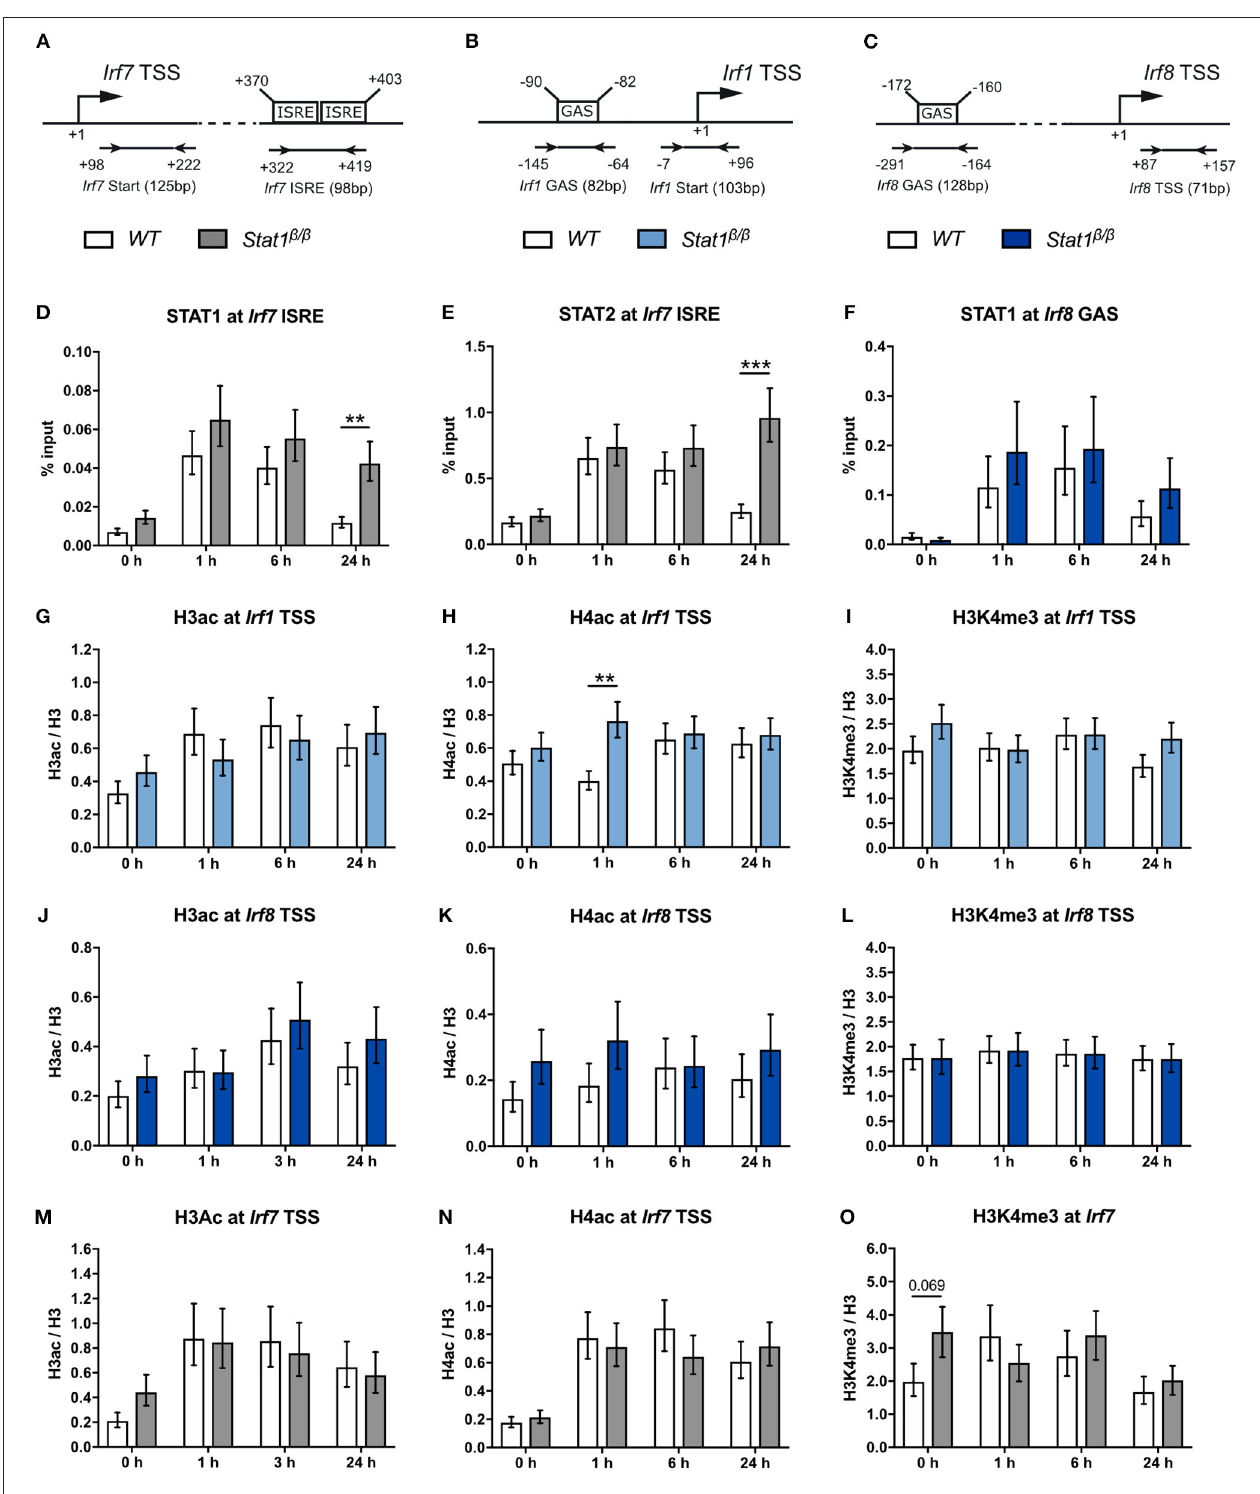
FIGURE 5 | STAT1 and IRF1 binding to the Irf7 and Irf8 promoters and H3ac and H4ac and H3K4me3 around the Irf1 , Irf8, and Irf7 TSS before and after IFN γ treatment. (A–C) Schematic representation of the murine Irf7 (A) , Irf1 (B) , and Irf8 (C) promoter regions. GAS and ISRE sites, the TSS and the position of the primers used for the ChIP analyses are depicted. (D–O) BMDMs from WT and Stat1 β/β mice were stimulated with IFN γ for the times indicated or left untreated (0h). STAT1 and STAT2 binding at the Irf7 ISRE (D,E) and STAT1 binding at the Irf8 (F) GAS element was analyzed by ChIP. H3 pan-acetylation (H3ac), H4 pan-acetylation (H4ac), and H3 lysine 4 trimethylation (H3K4me3) around the Irf1 (G–I) , the Irf8 (J–L), and the Irf7 (M–O) TSS was determined by ChIP. Data were normalized to the input control (D–F) or the total levels of H3 (G–O) . Mean values ± SE from three to four independent experiments are shown; ** P ≤ 0.01 , *** P ≤ 0.001 . Significances are only indicated for the comparisons between